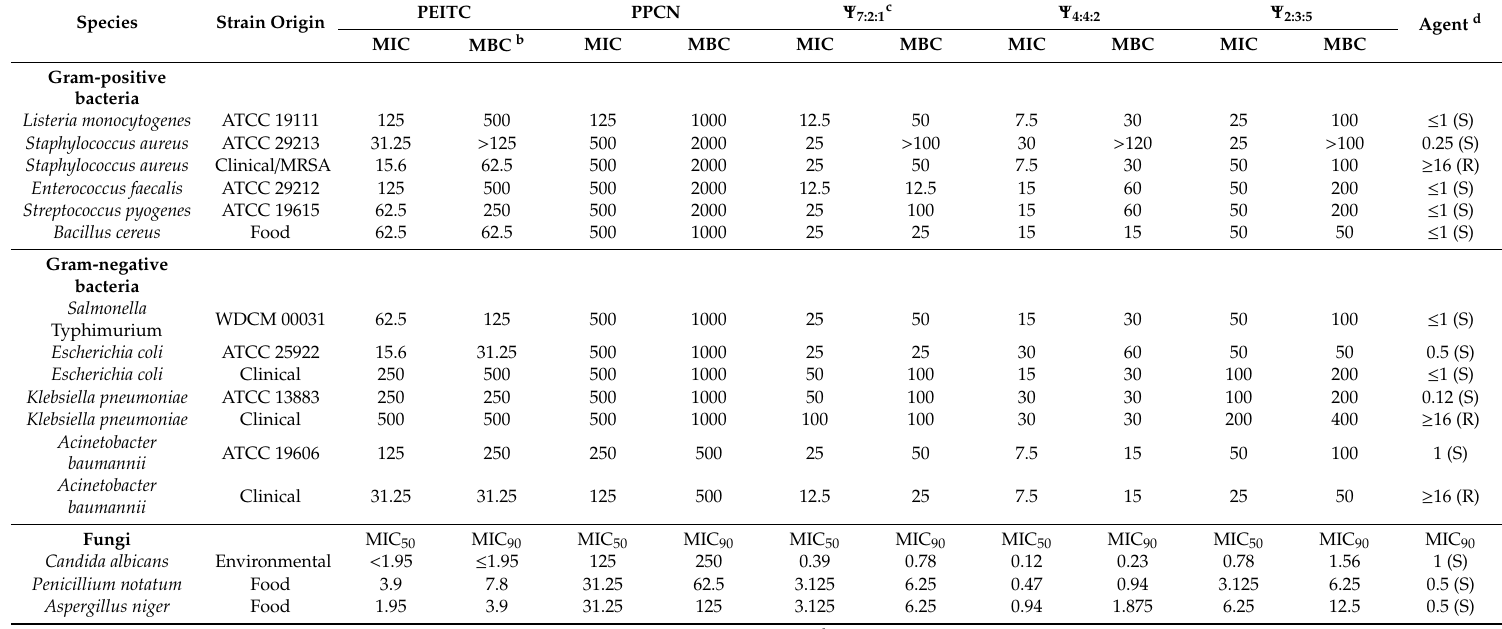
Table 4. Antimicrobial activities of 2-phenylethyl ITC (PEITC) and 3-phenylpropanenitrile (PPCN), and mixed solutions of PEITC, PPCN and allyl ITC (AITC), in di ff erent ratios Ψ PEITC:PPCN:AITC against tested strains by microdilution assay a